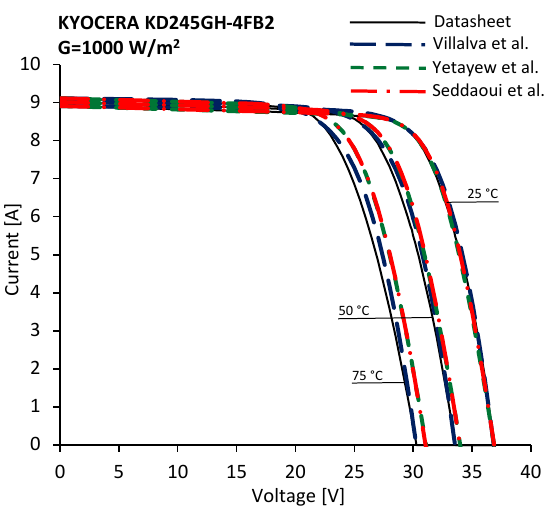
Figure 11. Comparison between the issued I-V characteristics of Kyocera KD245GH-4FB2 at G = 1000 W/m 2 and the characteristics calculated by means of the Villalva et al ., the Yetayew et al . and the Seddaoui et al . models.